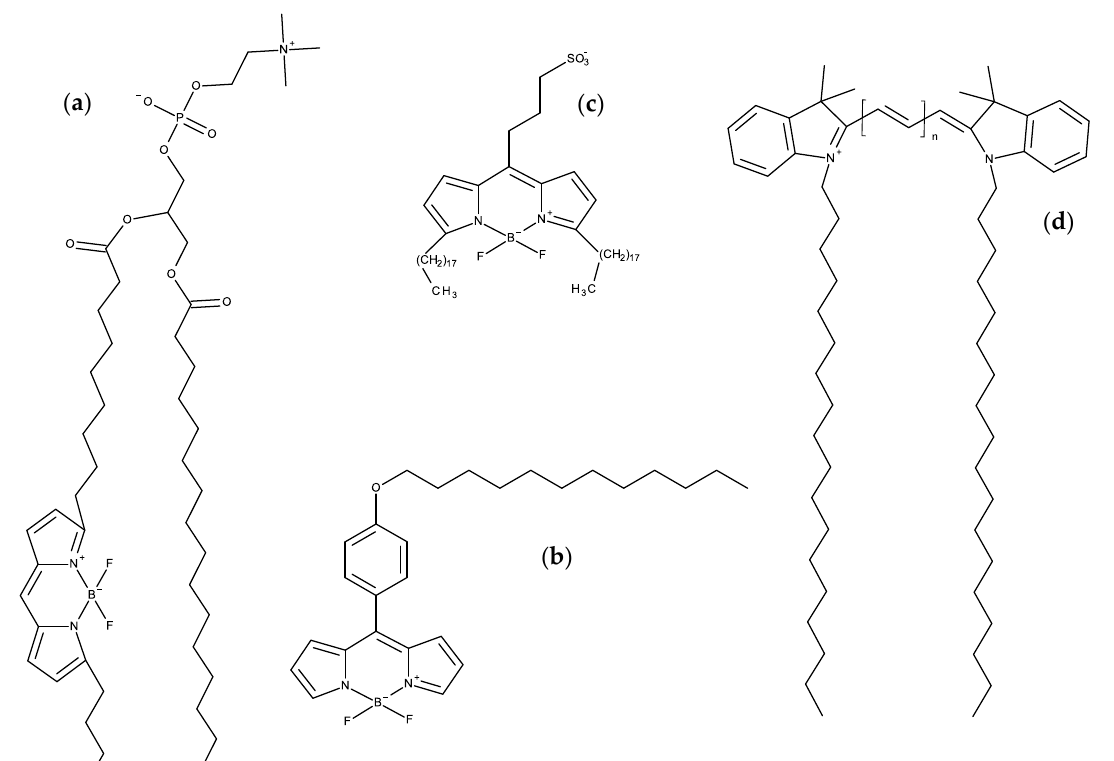
Figure 8. Structures of BODIPY and carbocyanine probes. ( a ) (1-hexadecanoyl-2-(4,4-difluoro-5-butyl-4-bora-3a,4a,diaza-s-indacene-3-nonanoyl)- sn -glycero-3-phosphocholine); ( b ) (4,4′-difluoro-4-bora-5-(p-oxododecyl)phenyl-3a,4a-diaza-s-indacene) (FMR-2); ( c ) 8-[(2-sulfonatoethyl)amino]-4,4-difluoro-3,5-dioctadecyl-4-bora-3a,4a-diaza-s-indacene (BNP); ( d ) generic structure of symmetric C18:0-chain carbocyanines. n = 1: DiIC 18 (3) or DiI; n = 2: DiIC 18 (5) or DiD; n = 3: DiIC 18 (7) or DiR.